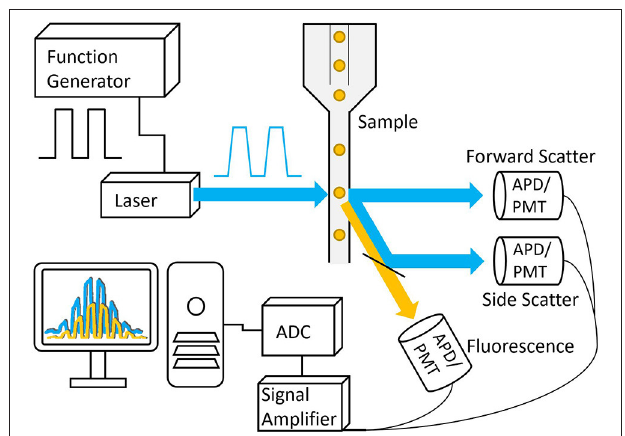
FIGURE 5 | Basic schematic of a frequency-domain TRFC system. A function generator is used to modulate the laser that is then focused onto a small interrogation point in the flow path of the sample. The scattered excitation light and fluorescence emission light are directed toward the detectors, producing analog signals that are amplified and digitized by the analog-to-digital